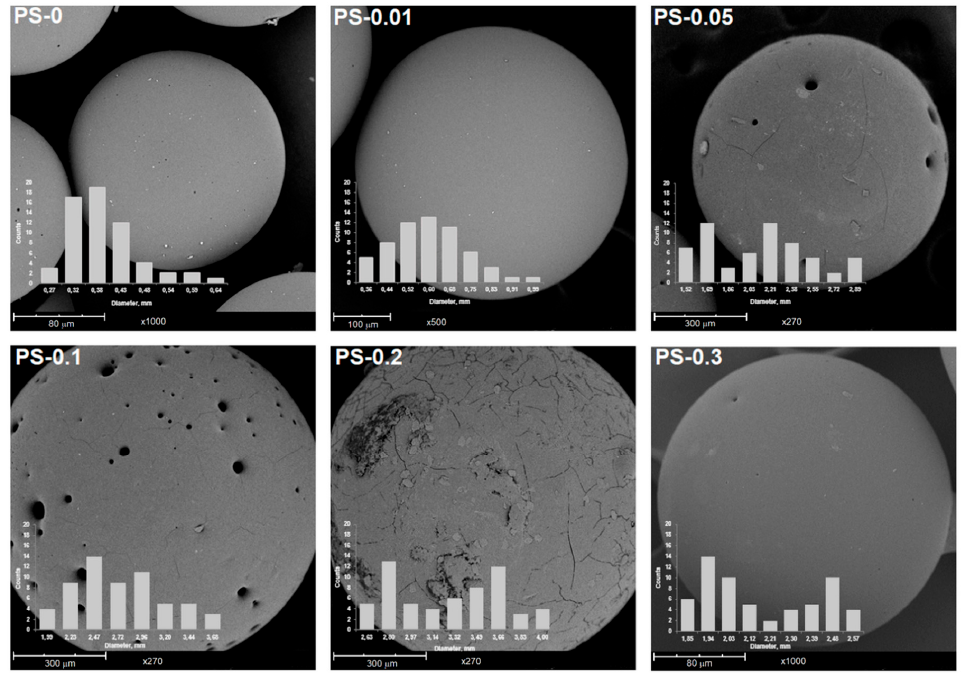
Figure 3. SEM images of pure PS and PS/rGO nanocomposites with particles size distribution. Polymers 2020 , 12 , 1468